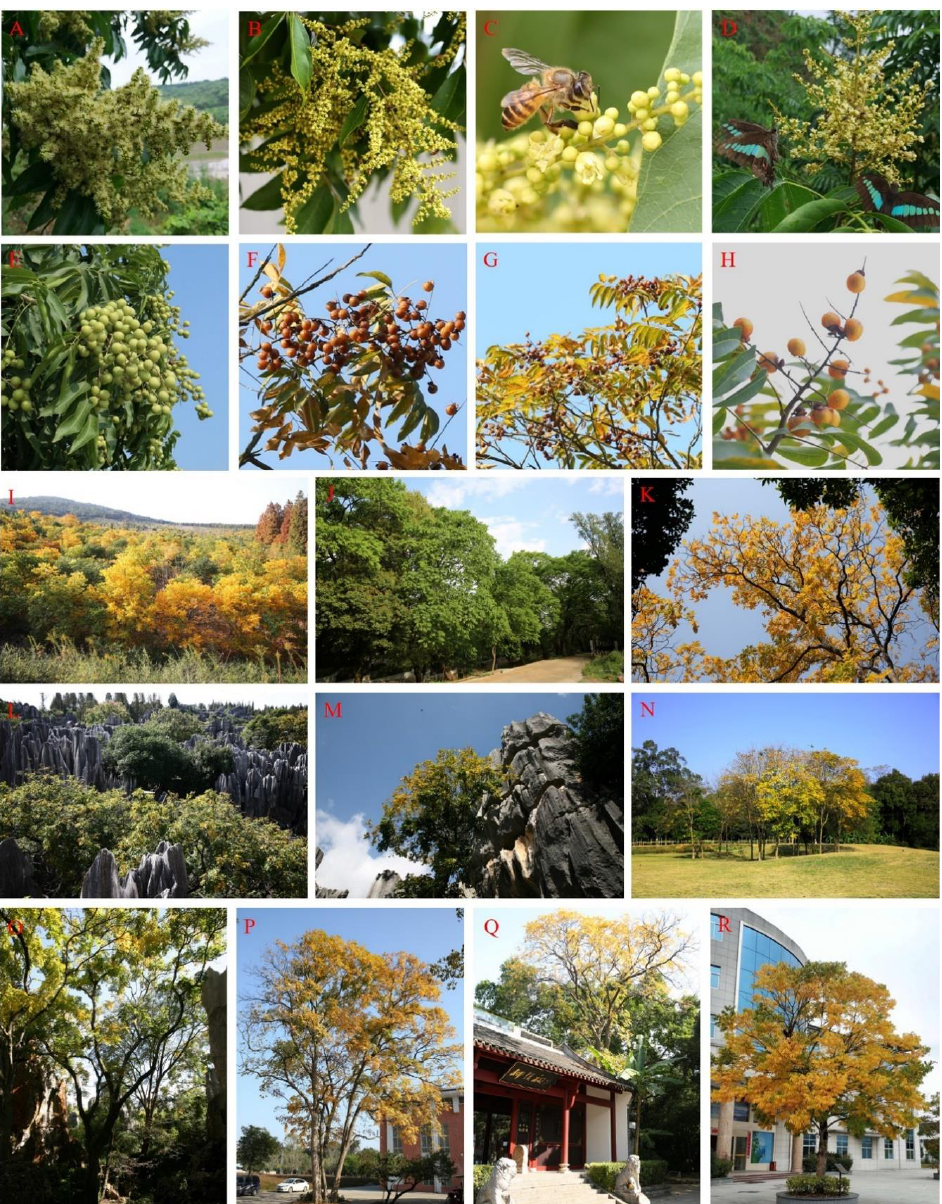
Figure 3. Ornamental and ecological value of different phenological stages in S. mukorossi. ( A ) – ( B ) Blooming functional male flowers on large yellow panicle inflorescences; ( C ) – ( D ) Bee and butterfly pollination; ( E ) – ( H ) Developing fruits and golden yellow fruits in the mature stage; ( I ) – ( K ) Landscaping with S. mukorossi along roadsides in summer and fall in southern China; ( L ) – ( O ) S. mukorossi trees in stone forest and parkland of Stone-Forest Scenic Spot in Yunnan Province; ( P )–( R ) Fully turned yellow leaves of S. mukorossi in the courtyard of the Guangxi Eco-engineering Vocational and